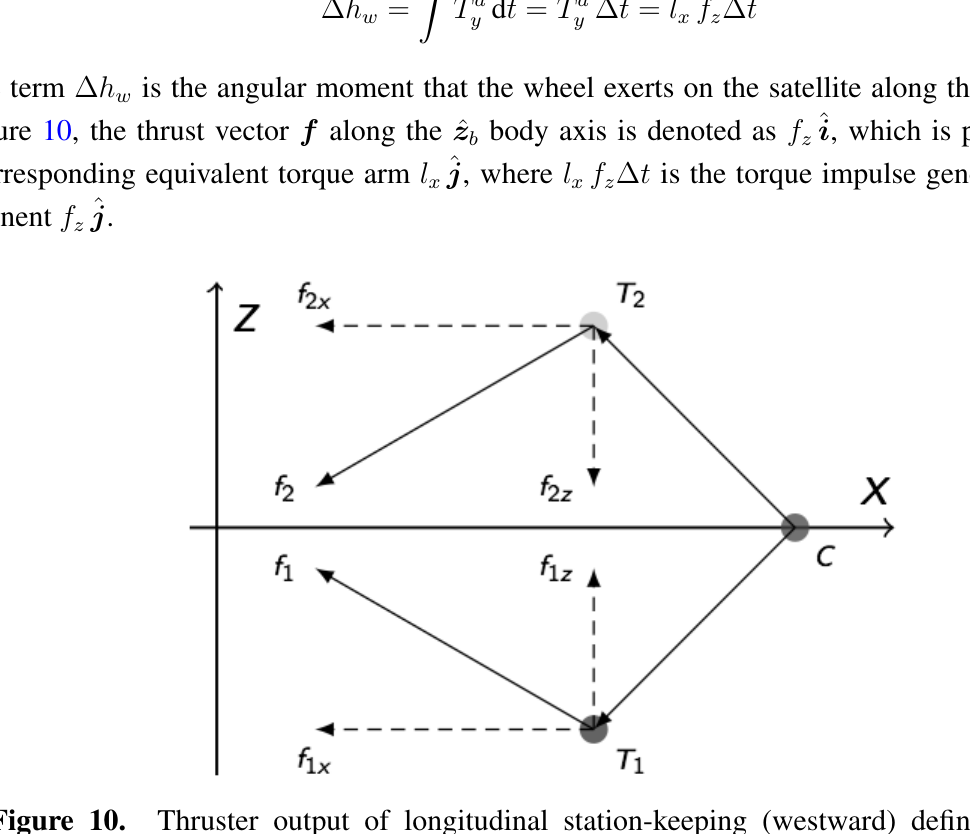
Figure 10. Thruster output of longitudinal station-keeping (westward) defined in the body